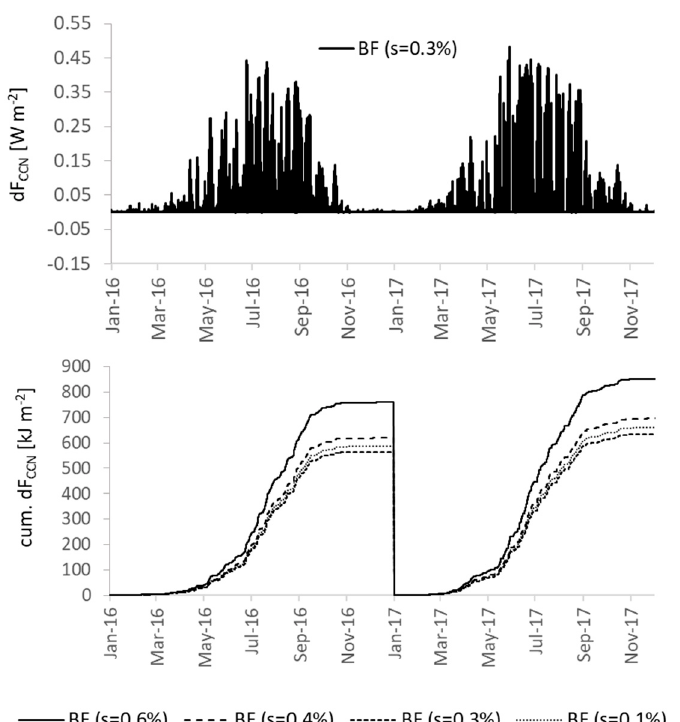
Figure 8. Approximated direct radiation effect of secondary organic aerosols ( F SOA ) for remote Black Forest conditions during 2017. Upper panel: Pattern of F SOA during 2017; bottom panel: Difference between pure beech and a 50% beech/fir mixture in W m − 2 (left axis) and the cumulative change for 50% fir admixture (broken line).